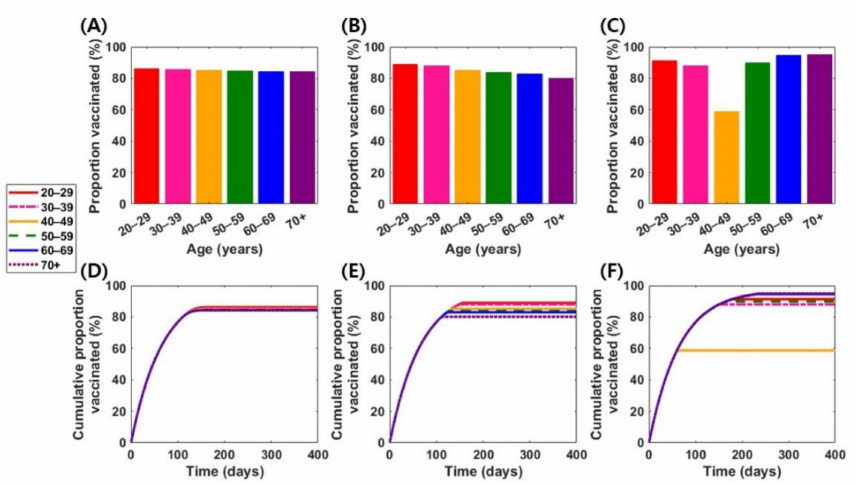
Figure 4. Optimal vaccination strategies in various vaccine scenarios with higher vaccine supply level (B = 70%). The first row represents age-specific levels of optimal vaccination coverage in the vaccine 1 ( A ), vaccine 2 ( B ), and vaccine 3 ( C ) scenarios. The second row represents time-dependent cumulative vaccination coverage levels under optimal vaccination schemes in the vaccine 1 ( D ), vaccine 2 ( E ), and vaccine 3 ( F )